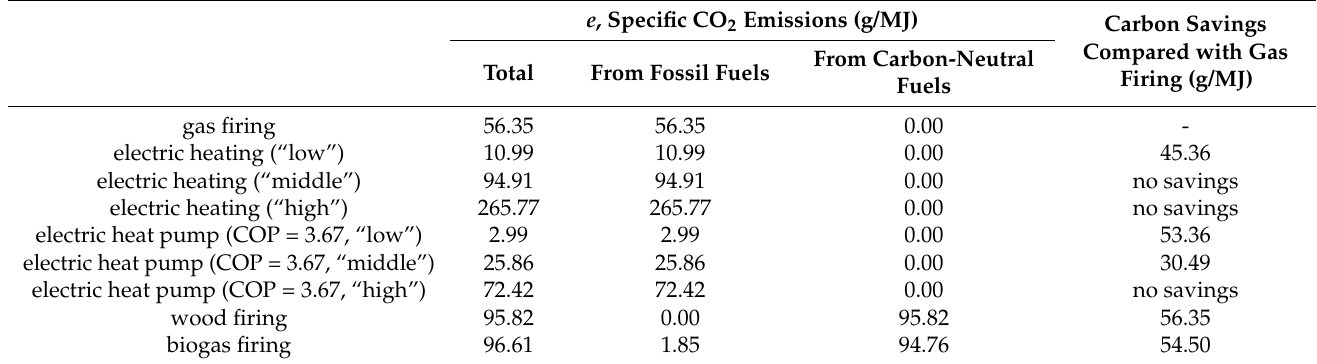
Table 1. CO 2 emissions and carbon savings per heat demand values used in the calculations. e , Specific CO 2 Emissions (g/MJ) Carbon Savings Compared with Gas From Carbon-Neutral Firing (g/MJ)Total From Fossil Fuels